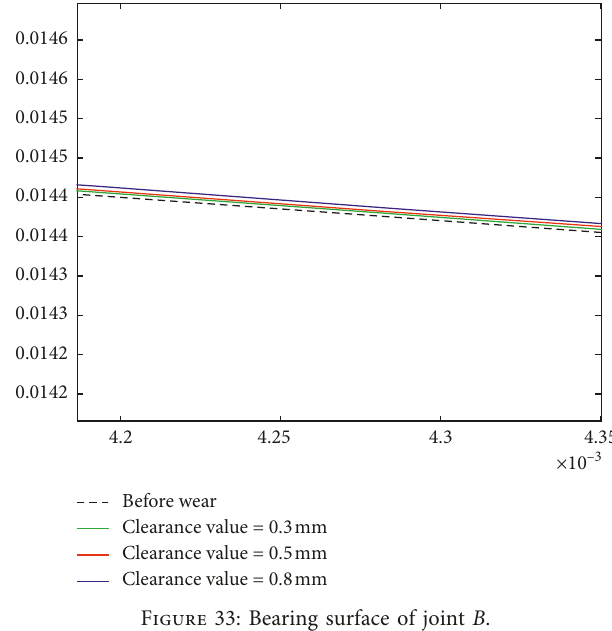
Figure 33: Bearing surface of joint B .